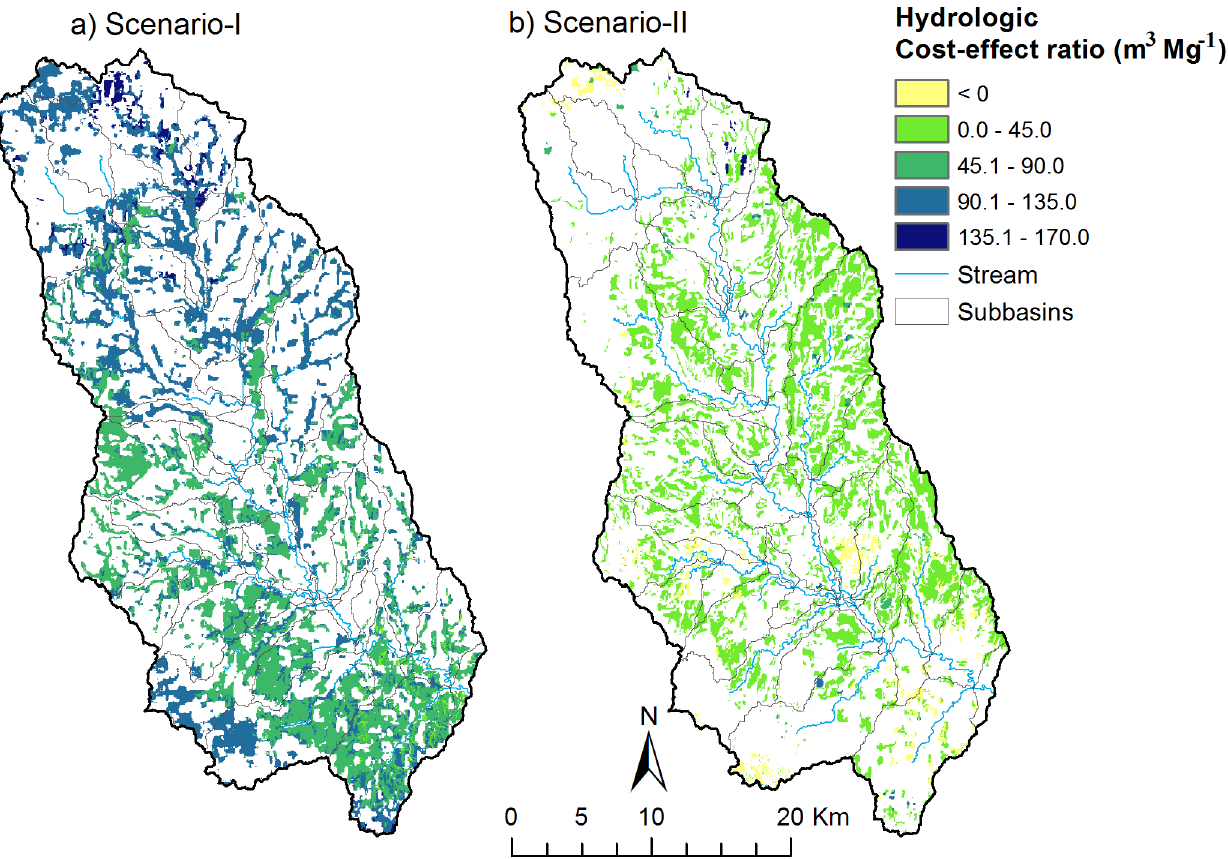
Fig 7. Map of hydrologiccost-effectiveness ratio for each HRU definedas averageannual(2002–2011) water yield reduction relative to the baselinesimulationdividedby the switchgrassproductionfor each HRU for the case of grasslandconversion(a) and marginalcropland